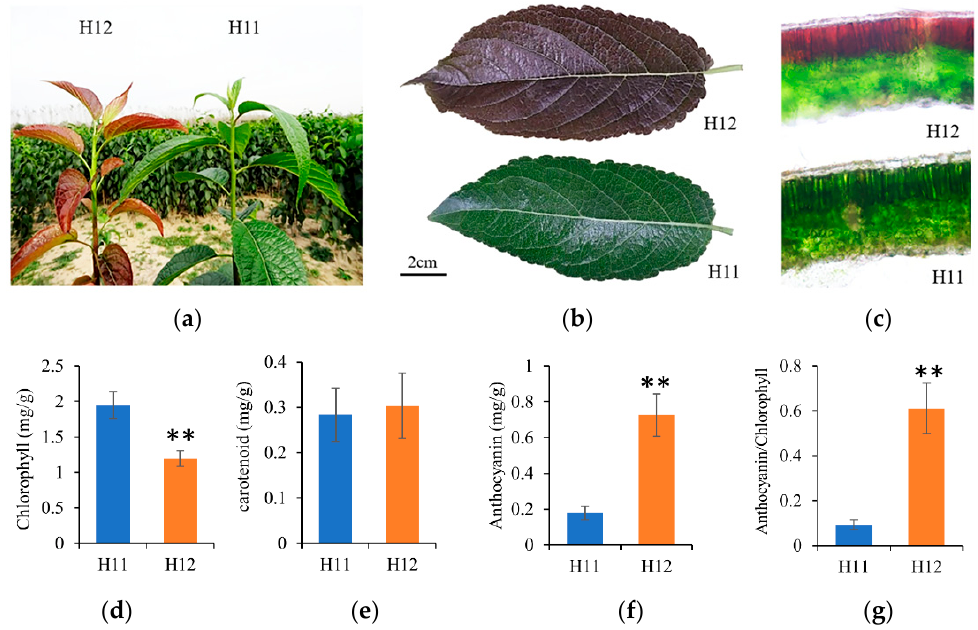
Figure 1. Leaves of E. ulmoides “ Huazhong No. 12” (H12, red) and E. ulmoides “ Huazhong No. 11” (H11, green, CK). ( a ) Leaves from H12 and H11 seedlings; ( b ) mature leaves of H12 and H11 used as experimental materials; ( c ) bare-hand sectioning of H12 and H11 leaves observed under the light microscope; ( d – f ) chlorophyll, carotenoid, and anthocyanin content in leaves of H11 and H12; and ( g ) anthocyanin and chlorophyll content ratio in leaves of two varieties. Data indicate means ± STDEV ( n = 12, p < 0.01, comparison method ANOVA). ** means that there is a significant difference in the pigment content of H11 and H12, and the difference level reaches p < 0.01.